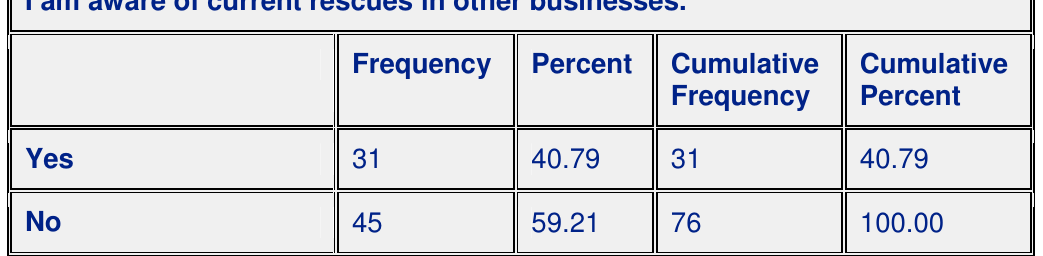
Table 6: Awareness of current rescues in other businesses I am aware of current rescues in other